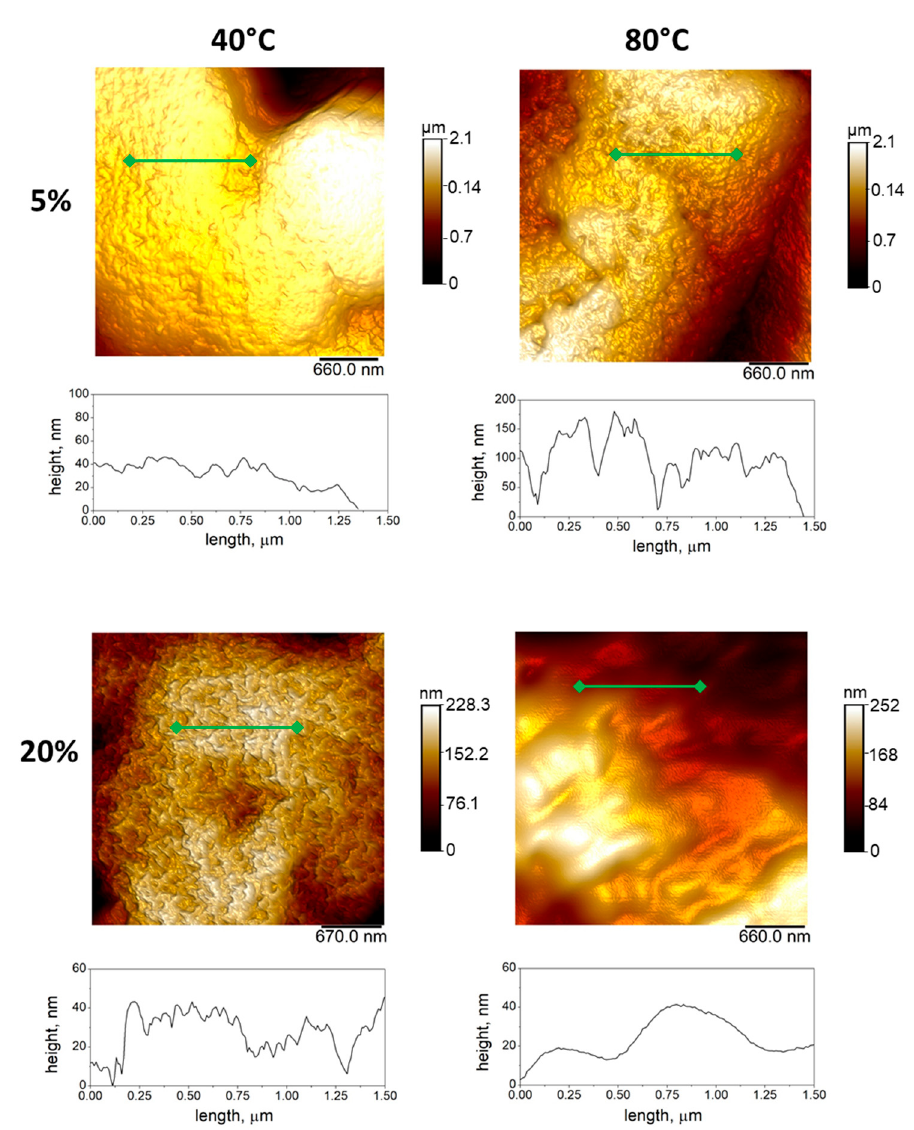
Figure 3. Quantitative analysis of surface morphology via AFM: images collected from samples with different polymer concentration (i.e., 5 and 20%) and different casting temperature (i.e., 40 and 80 ◦ C). Below the images, profiles at the sub-micrometric scale corresponding to the green cross-section lines were reported.